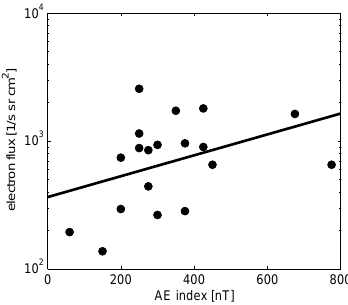
Fig. 10. Total energetic electron fluxes in the exterior cusp as a function of AE